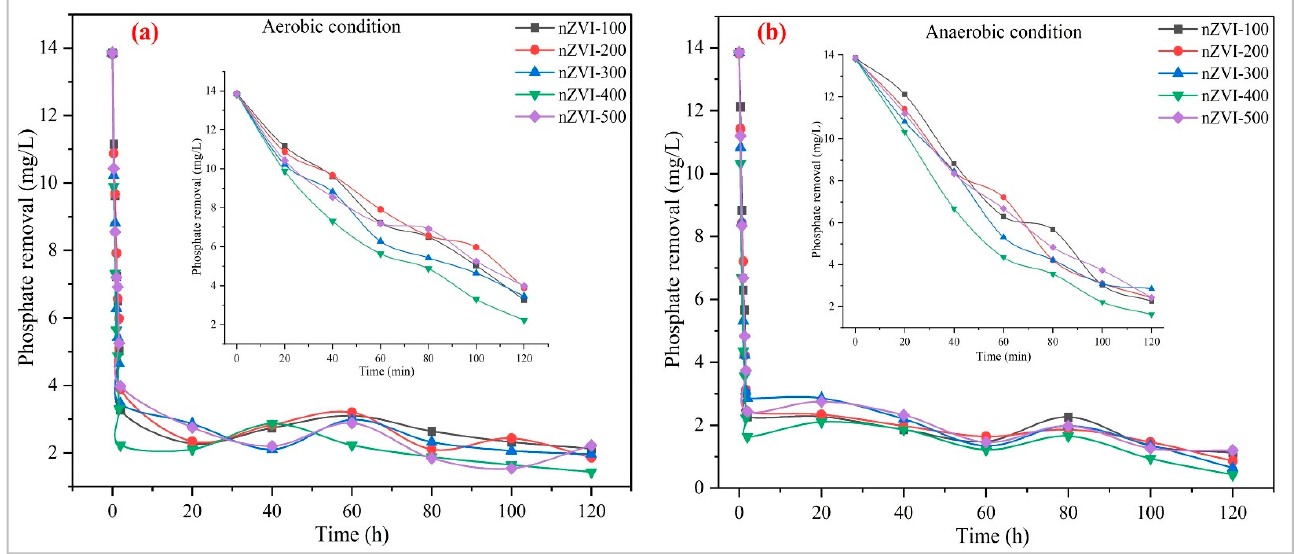
Figure 8. Phosphate removal at a different dosage of nZVI and conditions: ( a ) aerobic; the first 120 min of the aerobic treatment (inset) ( b ) anaerobic; the first 120 min of the anaerobic treatment (inset). However, the phosphorus content of wastewater samples was reduced to 1.12 mg/L after exposure to 100 mg/L of nZVI dosage. The results showed that using nZVI particles